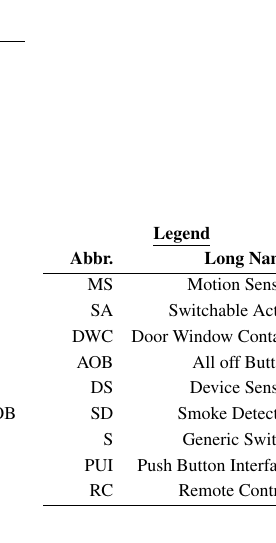
Table 3. Devices and their (typical) association with daily time